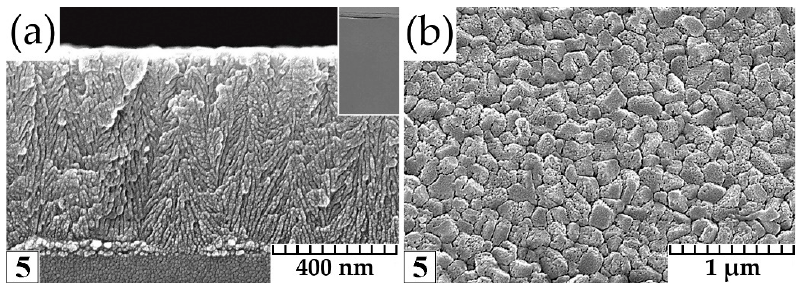
Figure 5. SEM image of the non-ordered anodic aluminum oxide film on the glass substrate obtained in the sulfuric–oxalic electrolyte (sample 5): ( a ) cross-section and photo transparency (insert); ( b ) surface.